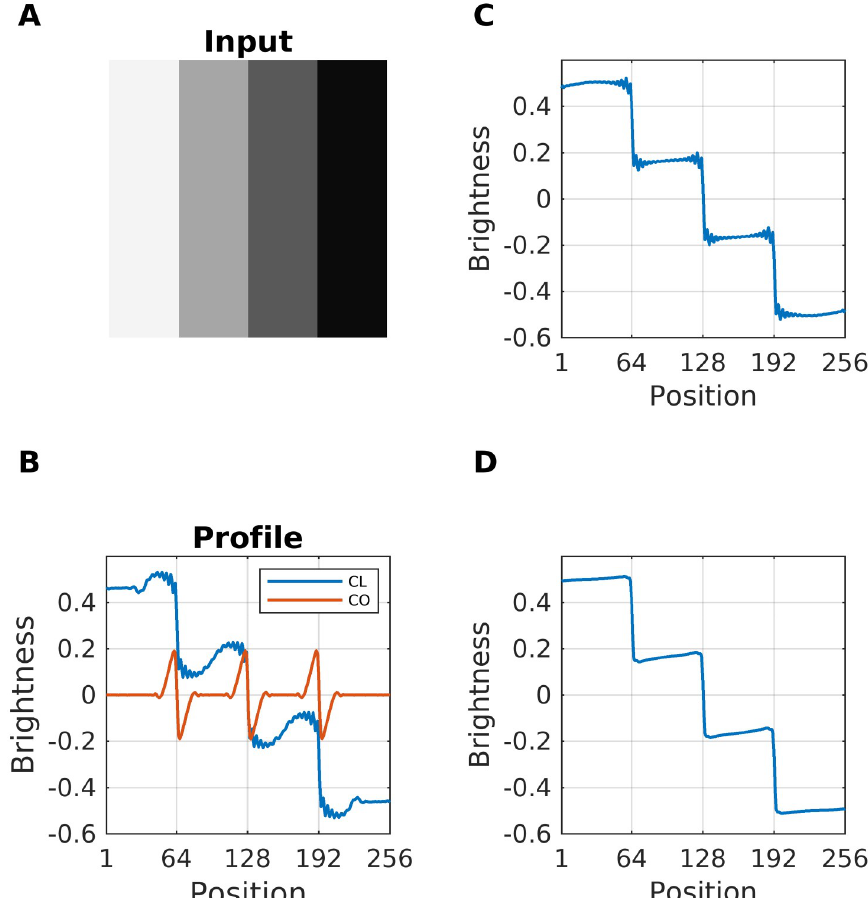
Fig 6. Contribution of each channel to brightness estimation. (A) A luminance staircase (giving rise to Chevreul’s Illusion) served as input. (B) The resulting brightness profiles are estimated at 10 iterations. The blue curve (legend label “CL”) uses only the Contrast-Luminance channel in Eq 5. The red curve (“CO”) uses only the Contrast-Only channel without responses to luminance. (C) Resulting brightness profile at the stop criterion for the Contrast- Luminance channel. Aliasing artifacts appear due to undersampling. (D) Brightness estimation with both channels. The Contrast-only channel eliminates undersampling. Notice that the sum involves the Gabor filters g of both contrast channels (i.e., Contrast- only and Contrast-Luminance). The regularization parameter controls the smoothness con- straint and is set to 0.01. The Laplacian is denoted by r 2 . The smoothness term and the Con- trast-only channel serve to reduce artifacts produced at discontinuities (Fig 6). The equation is solved iteratively with the conjugate gradient method. The method starts with an image z of 0 random values. The weights of z are updated such that the value of the cost function E ( z ) k k decreases with each iteration step. This gradient descent continues until a maximum of 100 iterations is reached, or until an error criterion is satisfied (see section D in S1 Text for more details). The filter responses R determine how the weights z are updated. Because the R are g k g higher at the edges, activity is iteratively propagated from the edges. Direction and orientation of activity spreading are determined by the odd-symmetrical Gabor filters that are used for encoding the image. Thus, image reconstruction (i.e., brightness estimation) proceeds accord- ing to a filling-in process.